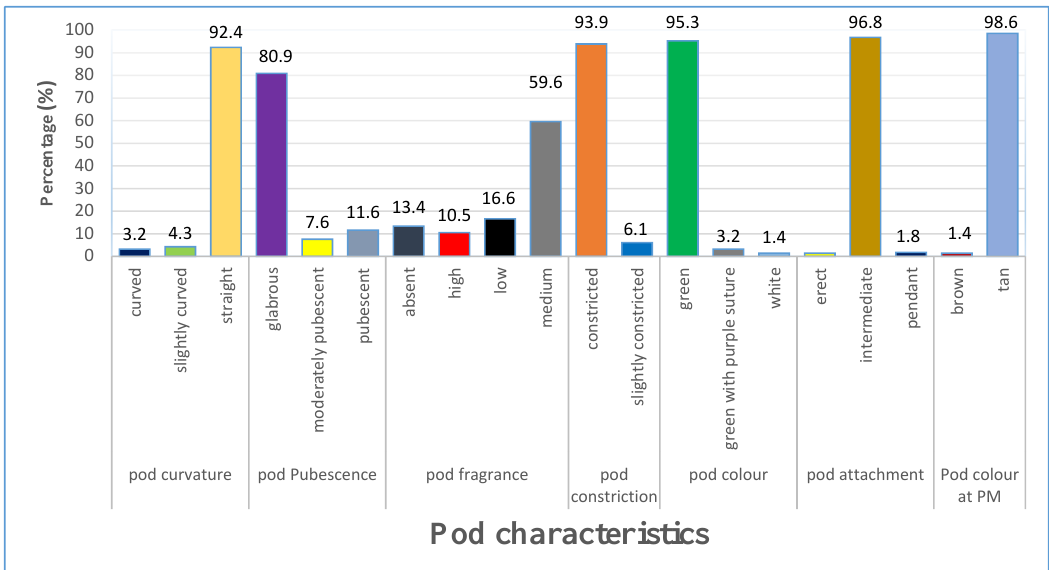
Figure 3. Variation in selected pod characteristics of lablab accessions.